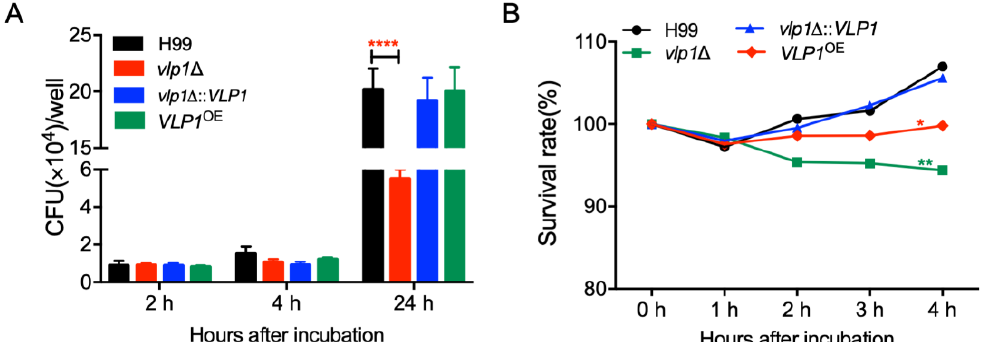
Figure 5. Vlp1 is required for Cryptococcus –macrophage interaction and survival in the host complement system. ( A ) The proliferation of Cryptococcus inside macrophages was performed using J774 macrophages. CFU numbers recovered from the macrophage culture after removing the nonadherent extracellular yeast cells and cultured for indicated times were used to determine intracellular proliferation and macrophage killing. ****, p < 0.0001 (determined by Mann–Whitney test). ( B ) The survival rate of the same strains as ( A ) after co-incubation with mouse serum was determined by the CFU numbers recovered from the co-incubation cultures after co-incubated as the indicated time. *, p < 0.05; **, p < 0.001.